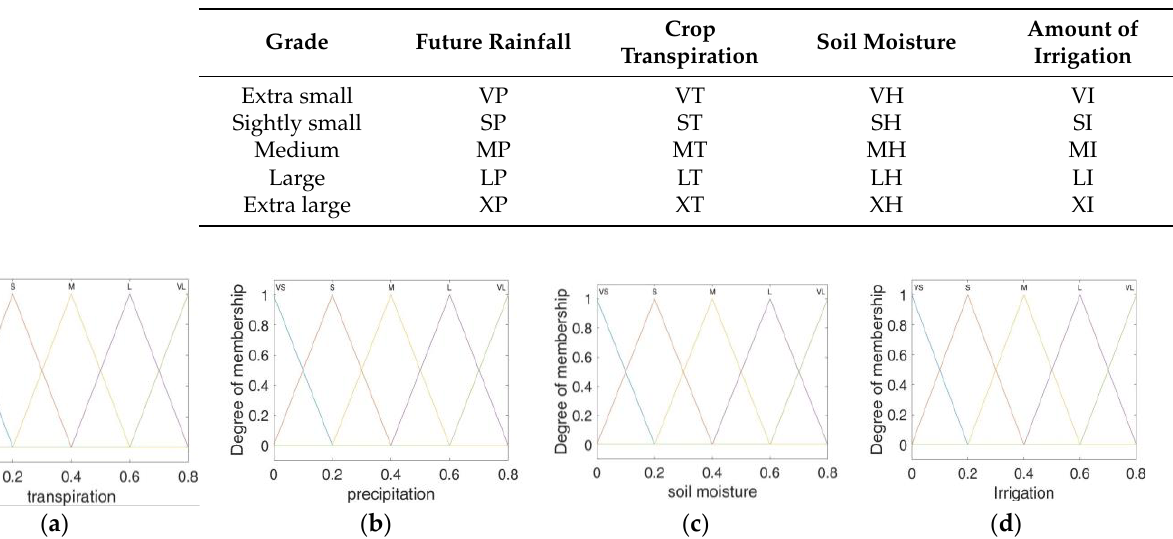
Table 3. The subset of fuzzy variables.